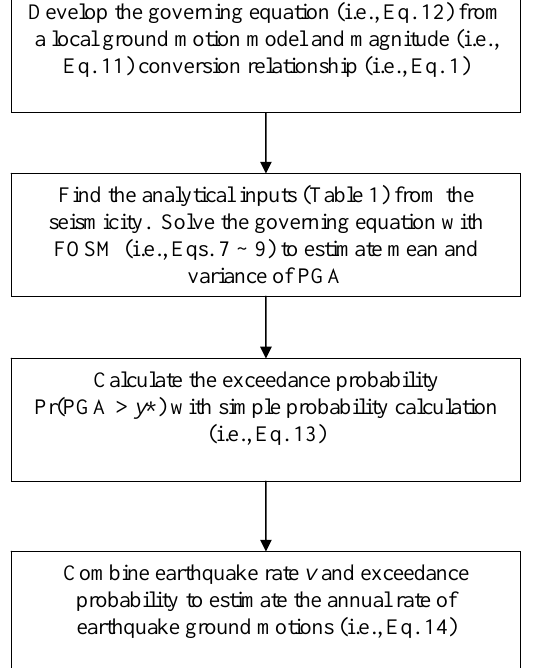
Fig. 3. A chart summarizing the FOSM application of this study to earthquake hazard assessment.